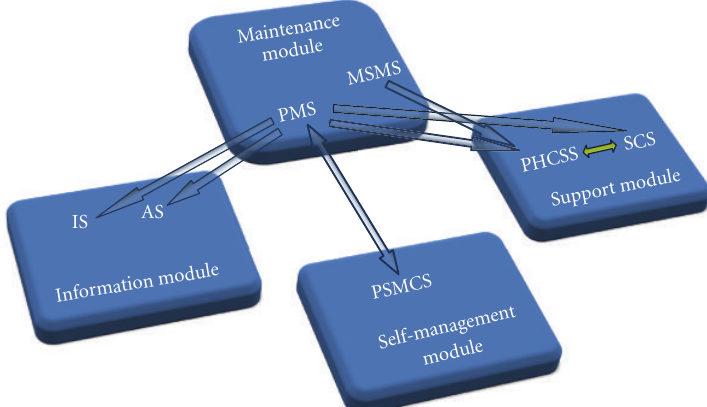
Figure 1: The architecture of Diabetes Mobile Virtual Platform (PMS: Patient Maintenance Service, MSMS: Medical Specialist Maintenance Service, PHCSS: Professional Health Care Support Service, SCS: Social Collaboration Service, PSMCS: Patient Self-Management Care Service, IS: Information Service, AS: Advertising